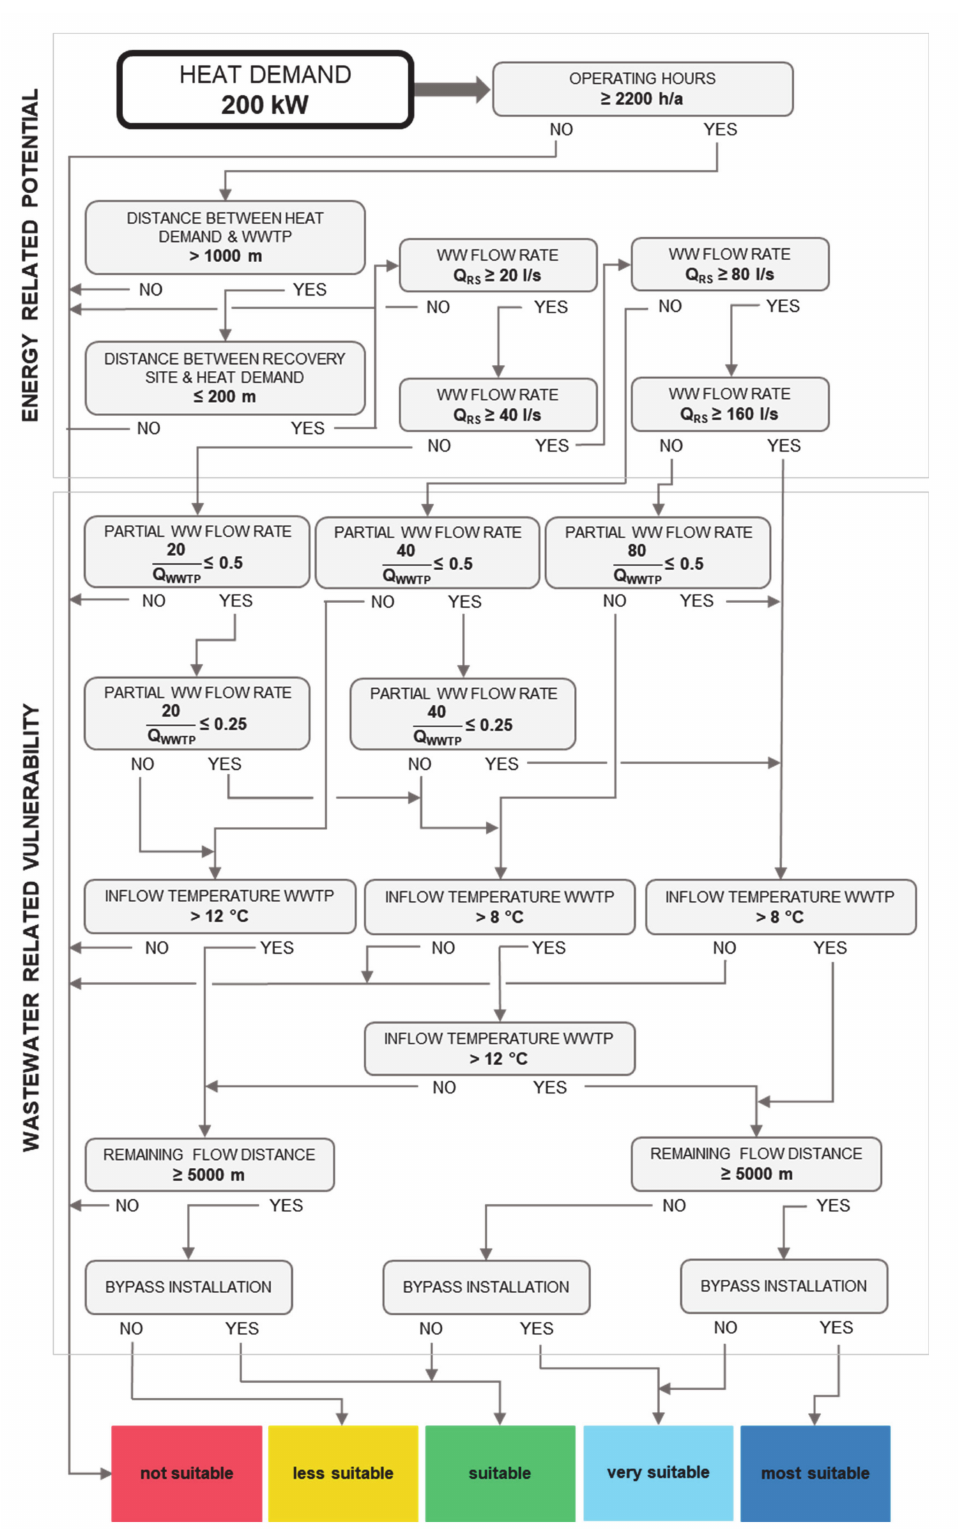
Figure A5. Relevance tree for an intended heat supply of 200 kW (own representation, based on